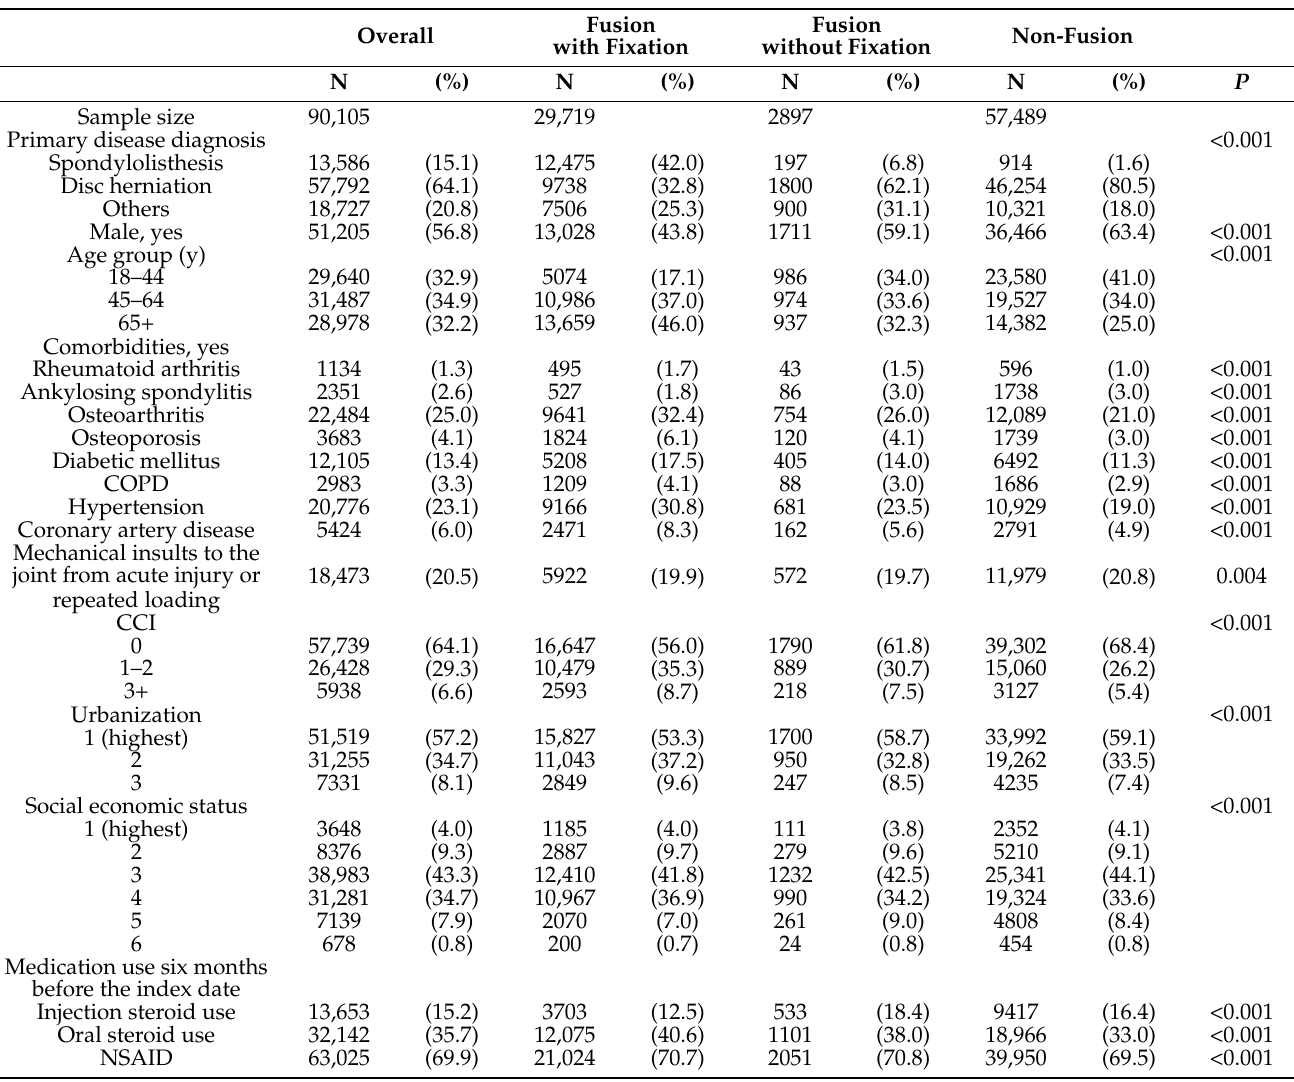
Table 1. Basic characteristics of patients diagnosed with degenerative disc disease and who first received lumbar discec- tomy